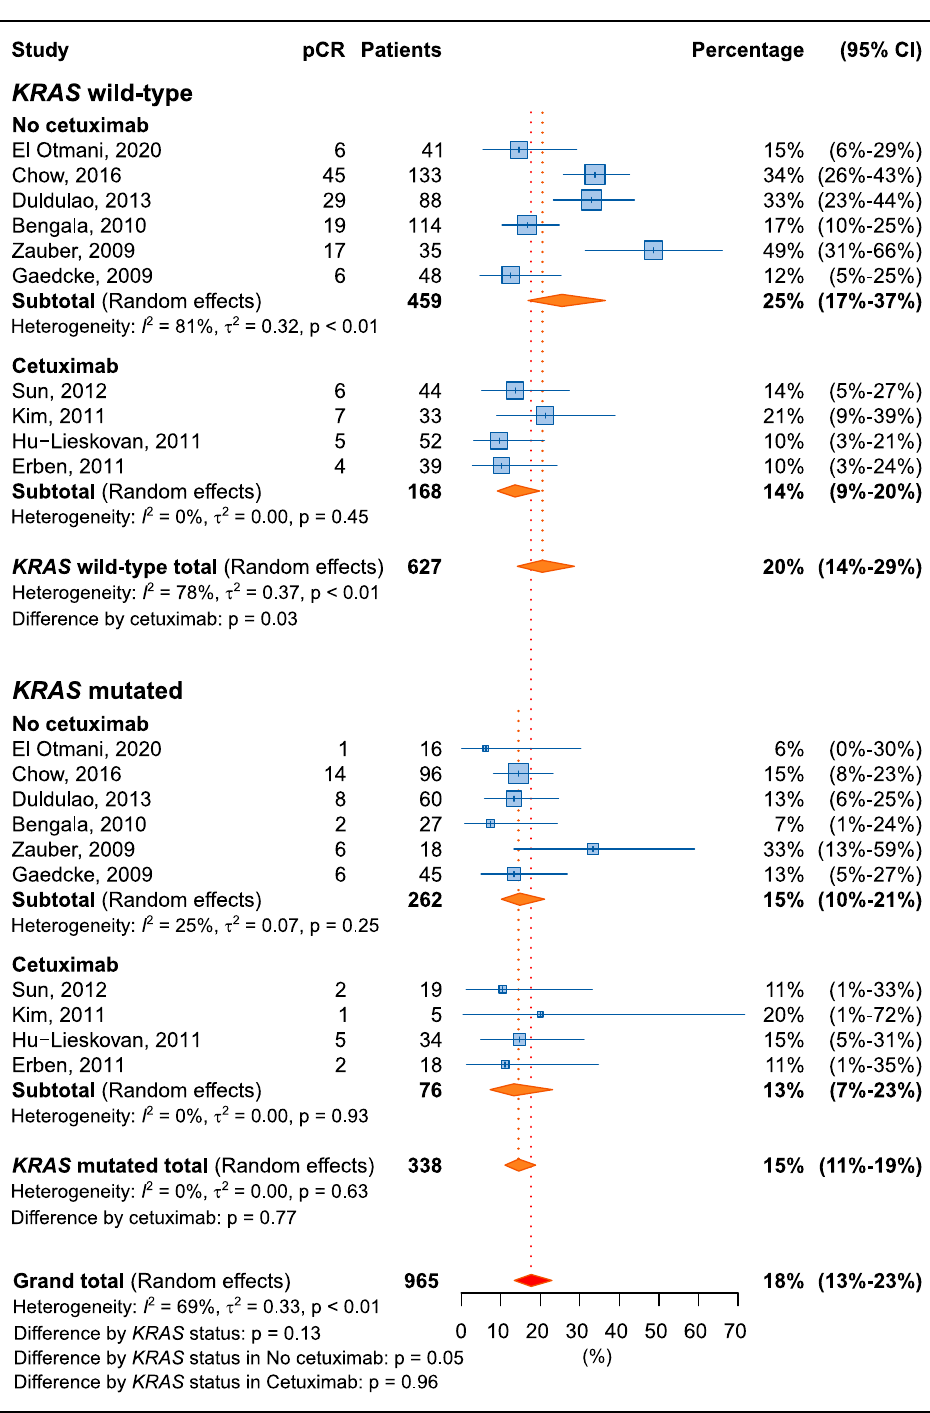
Figure 2. Forrest plot for percentage of pathological complete response (pCR) by KRAS mutation and cetuximab treatment.